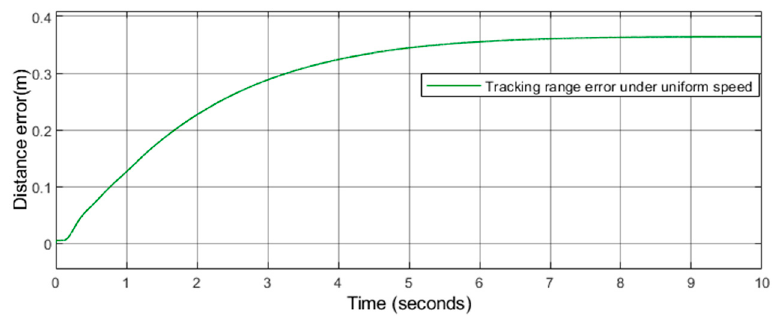
Figure 9. Tracking range error under uniform speed.